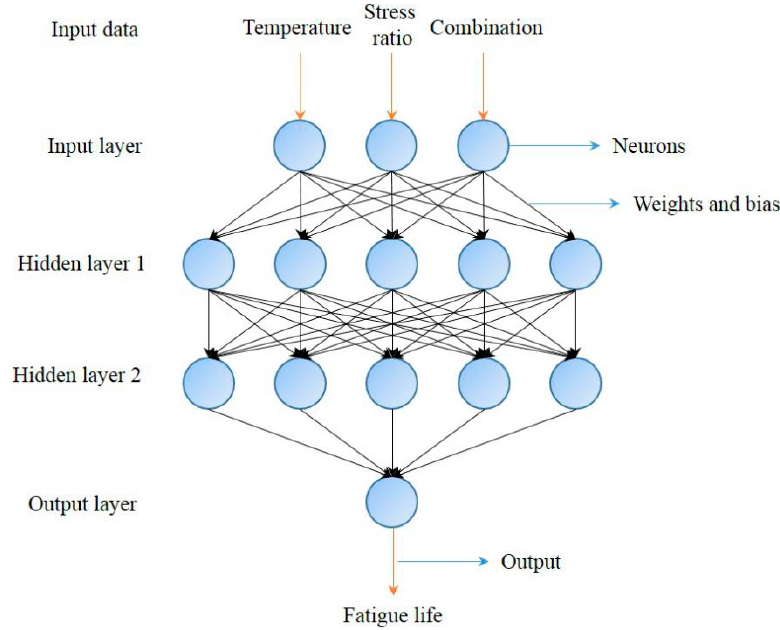
Figure 4. Network structure model of the mixtures.